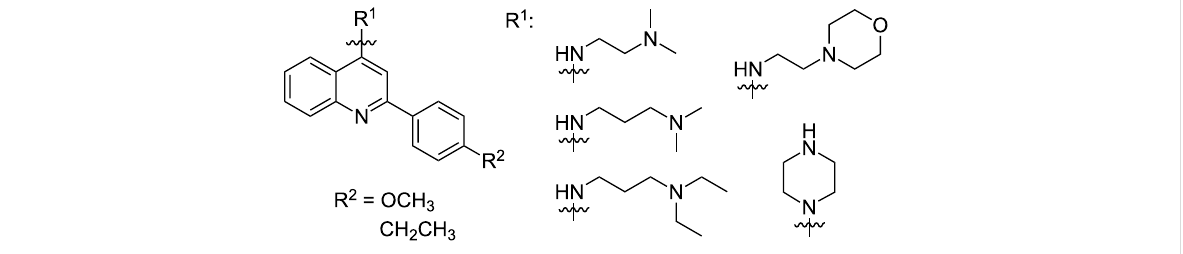
Figure 8: 4-Aminoquinolines developed by Cassel and co-workers [43] for disruption of oligonucleotide/TDP-43 binding.